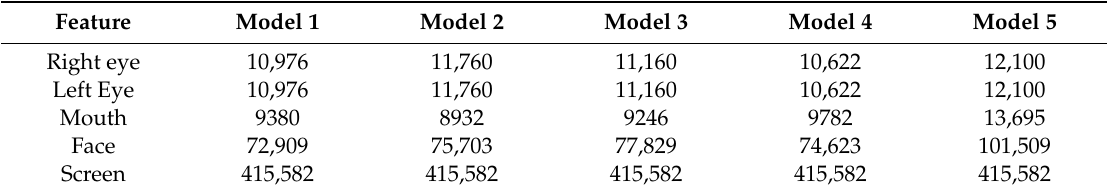
Table A1. Size (pixels) of interest areas.